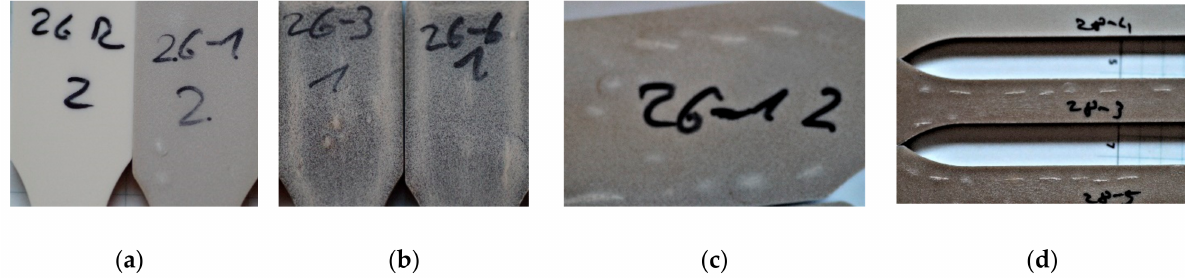
Figure 2. Tensile test bar immersed in water after 289 days; ( a ) 9:1-f-0-0 and 9:1-f-8.3-1.0 from left to right; ( b ) 9:1-f-25-1.0 and -1.5; ( c ) backside of ( a ) 9:1-f-8.3-1.0 showing a pattern of crevices on swollen particles; ( d ) 4:3-f-8-1.0 and 4:3-f-16-1.0 and 4:3-f-16-1.0 from top to down; the same pattern as in ( c ) can be seen in the composites with 16%